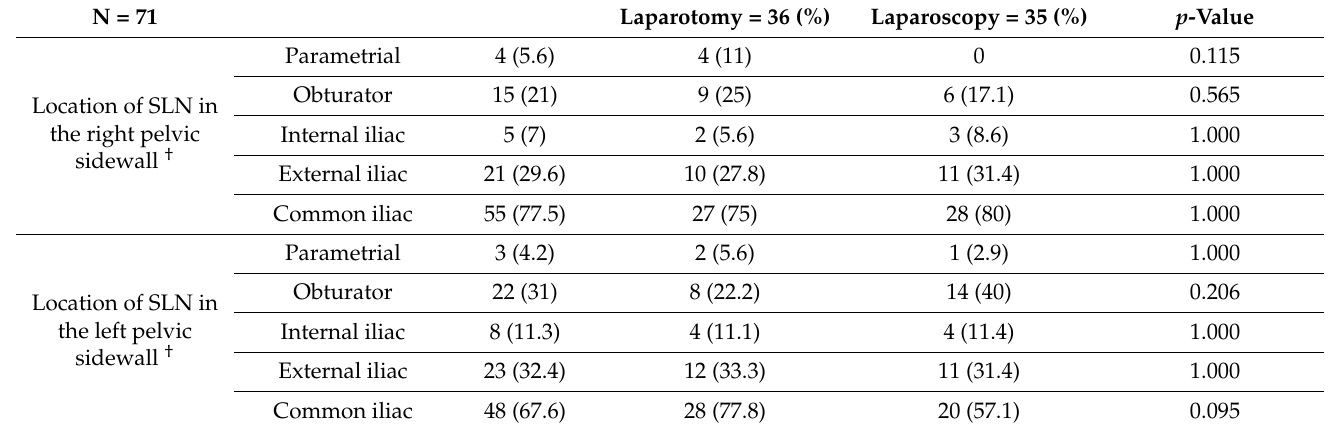
Table 2. Distributions of sentinel lymph nodes in open surgery and minimal-invasive